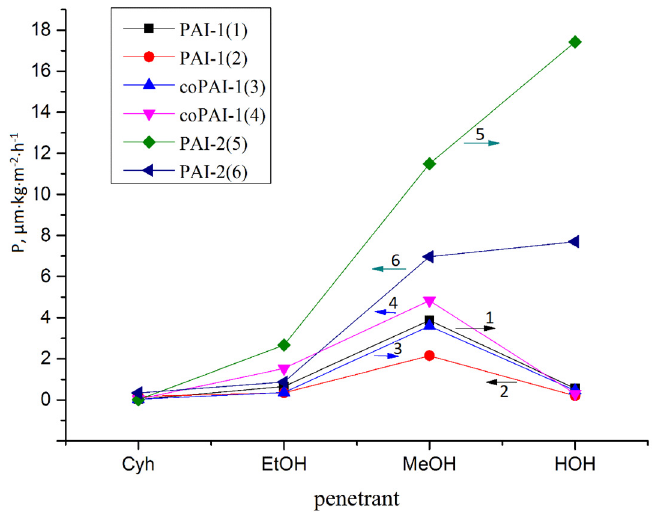
Figure 12. Diagram (general view) of the permeability rate values (P [ µ m · kg · m − 2 · h − 1 ]) of dense membranes (nonporous films) of the synthesized polymers PAI-1 ( 1 , 2 ), coPAI-1 ( 3 , 4 ), PAI-2 ( 5 , 6 ) in relation to penetrants of different polarities (Cyh—cyclohexane, EtOH—ethanol, MeOH—methanol, HOH—water). The mean values are shown, n ≥ 3. The order of penetrants during pervaporation: direction 1 ( → arrow on the diagram) Cyh → EtOH → MeOH → HOH; direction 2 ( ← arrow on the diagram) HOH → MeOH → EtOH → С yh.